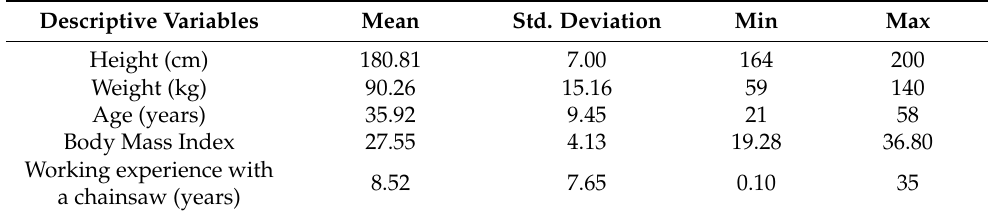
Table 2. General information from the chainsaw workers participating in the postural load study (N = 74). Descriptive Variables